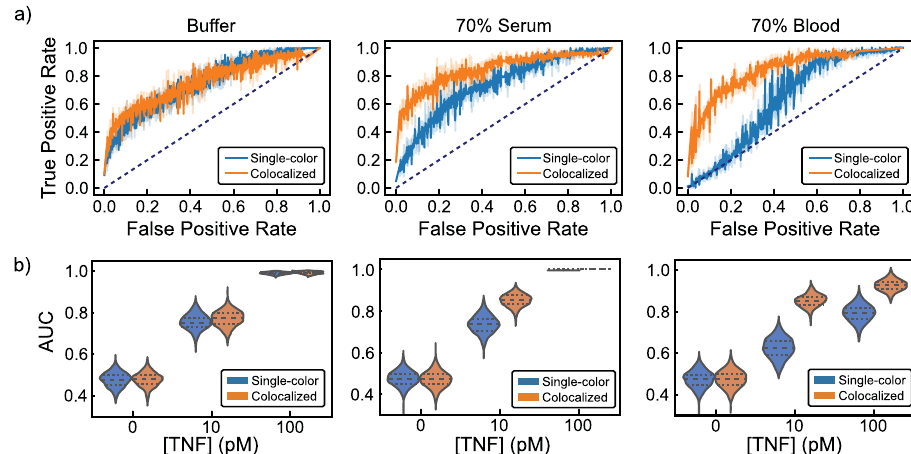
Fig.4|DiscriminatingTNF- α concentrationsusingsingle-colorandcolocalized methods in buffer, 70% chicken serum, and 70% human blood. a Bootstrapped ROCcurvesfrombinaryclassi fi cationbetween10pMTNF- α distributionsandTNF- α -free negative controls in buffer (left), 70% chicken serum (middle), and 70% human blood (right). Dotted lines indicate random guess. Raw data in SI Fig. S9.